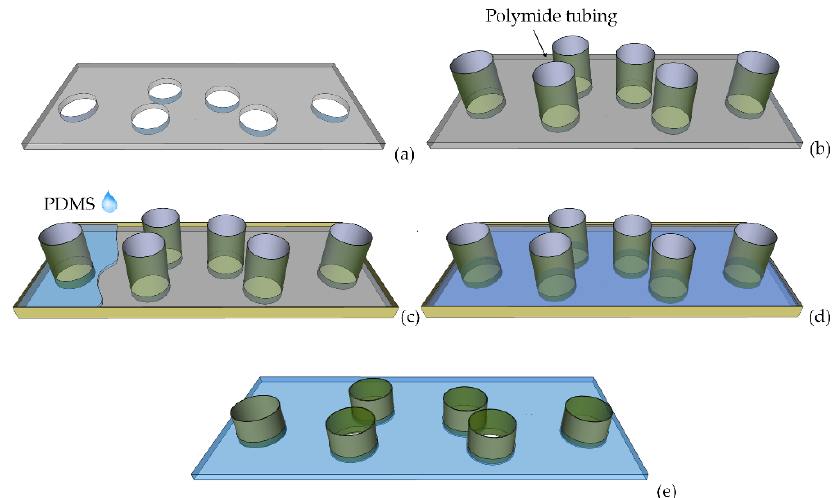
Figure 9. PMMA substrate mold after ( a ) milling holes and ( b ) inserting polymide tubing. ( c , d ) PDMS casting on the PMMA mold. ( e ) PDMS layer with integrated polymide tubing.